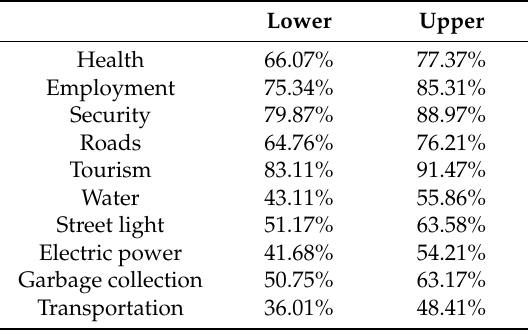
Table 5. Development factors of the industrial park, statistical inference.